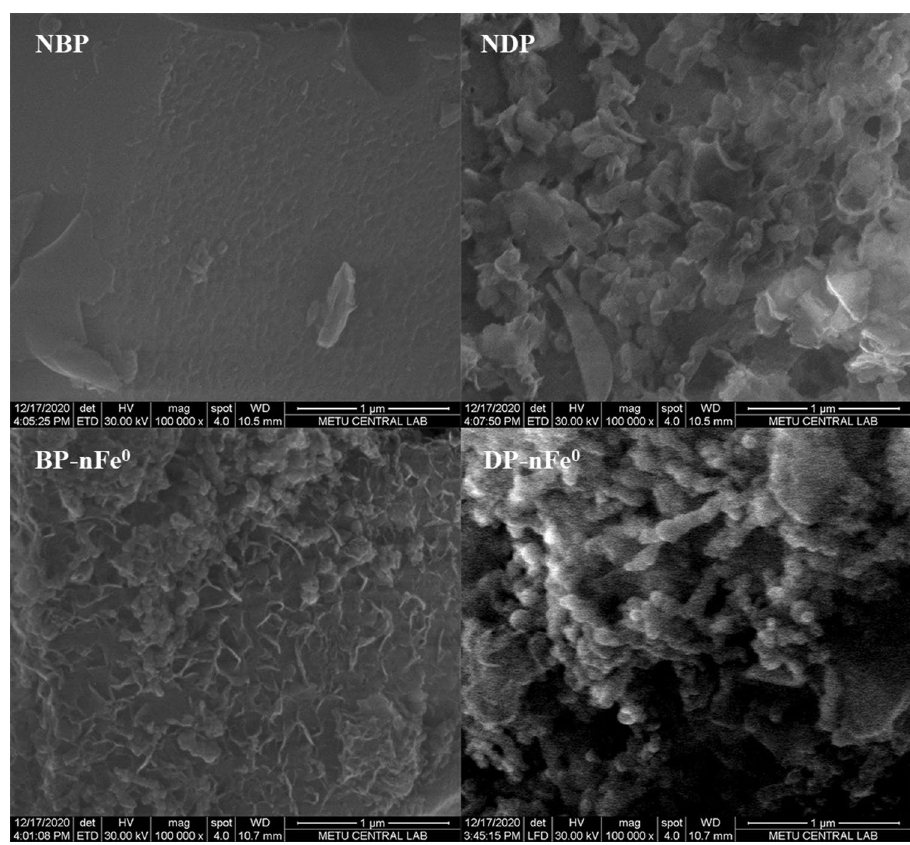
Fig. 1 SEM image of NBP, BP-